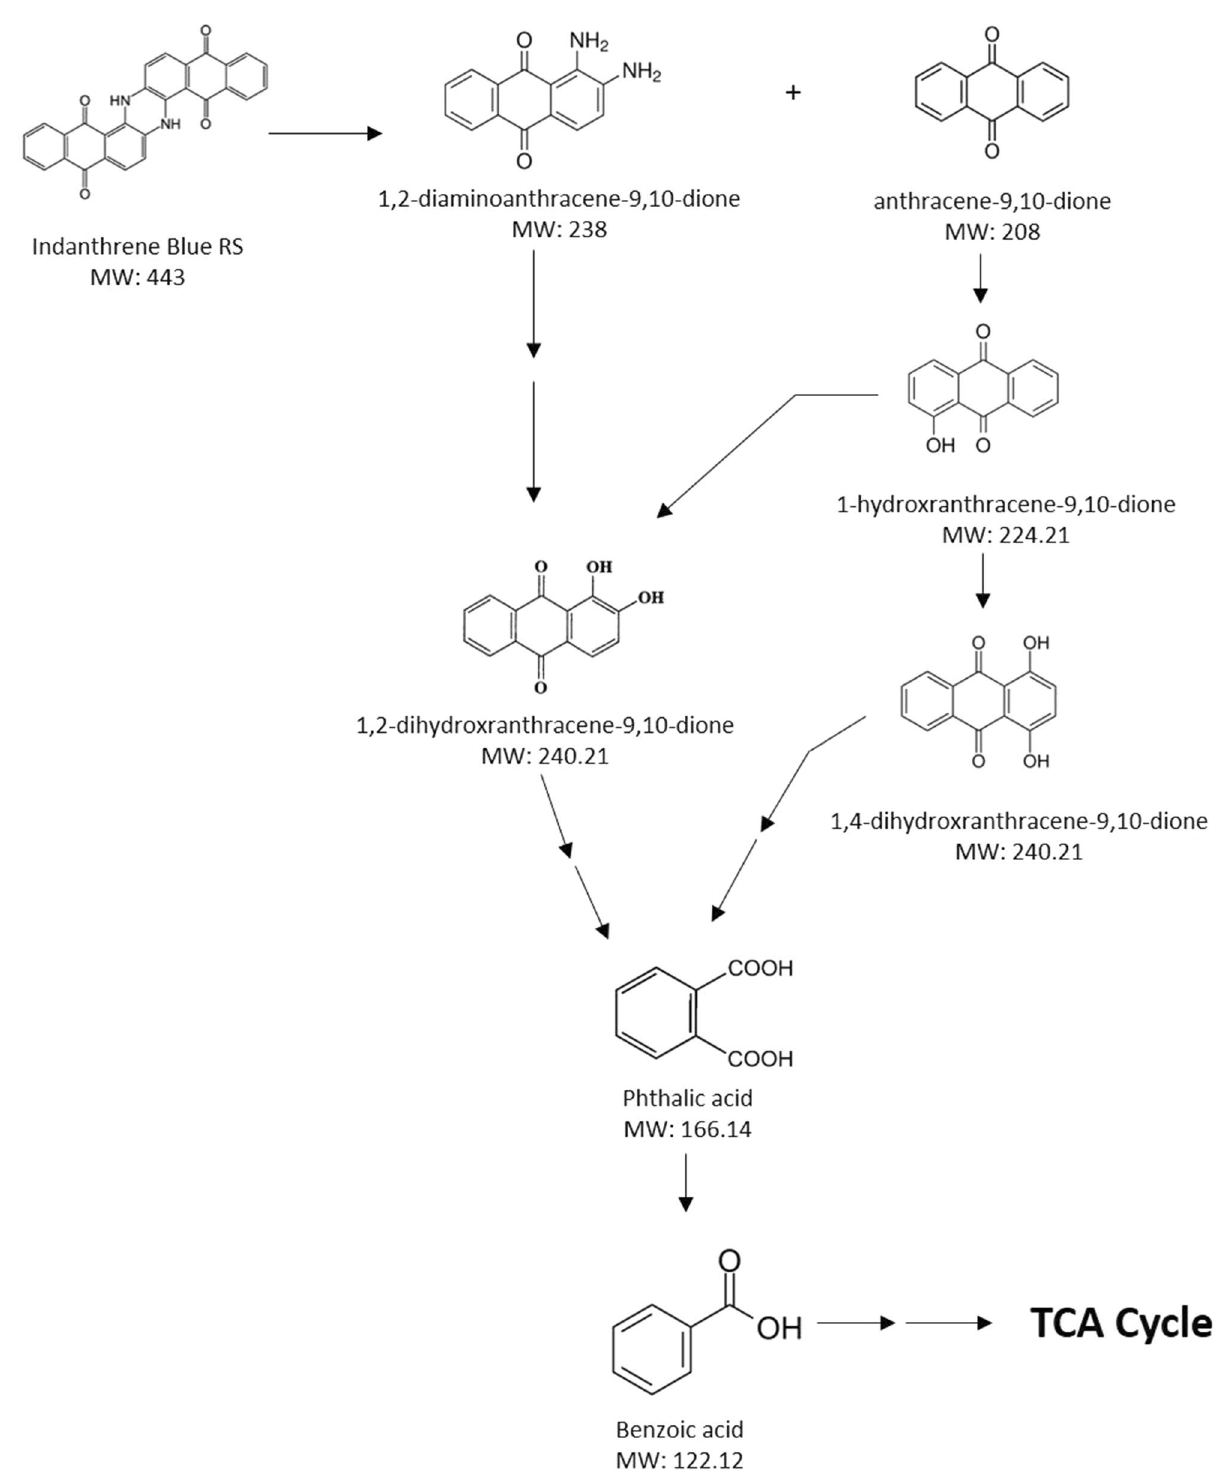
Figure 4. The proposed metabolic pathway of Indanthrene Blue RS degradation towards mineralization by